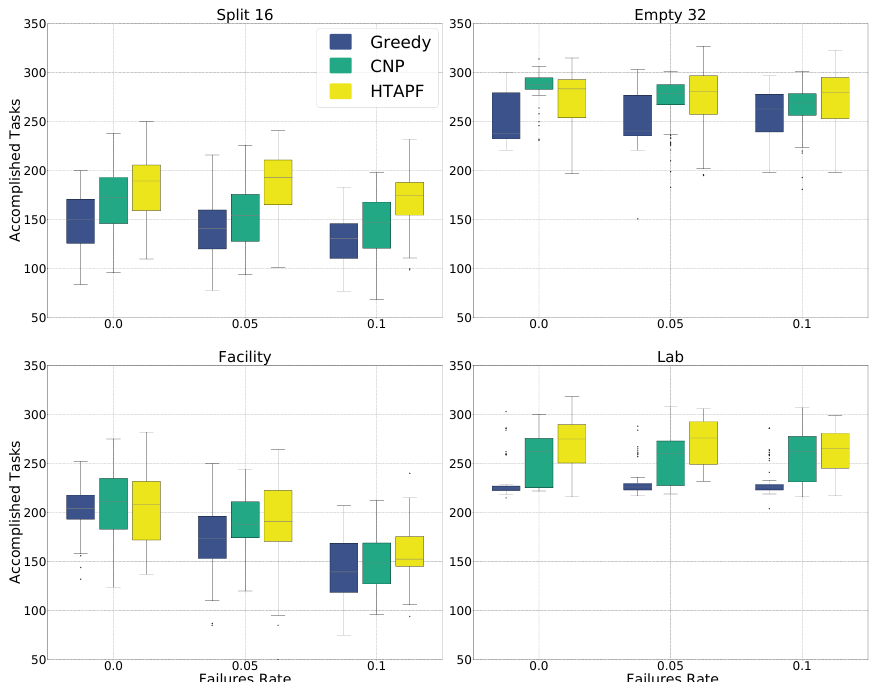
Figure 7. Number of accomplished tasks by the different approaches (greedy, CNP, and HTAPF) across the different environments, obtained with unlimited communication and variable robot failures